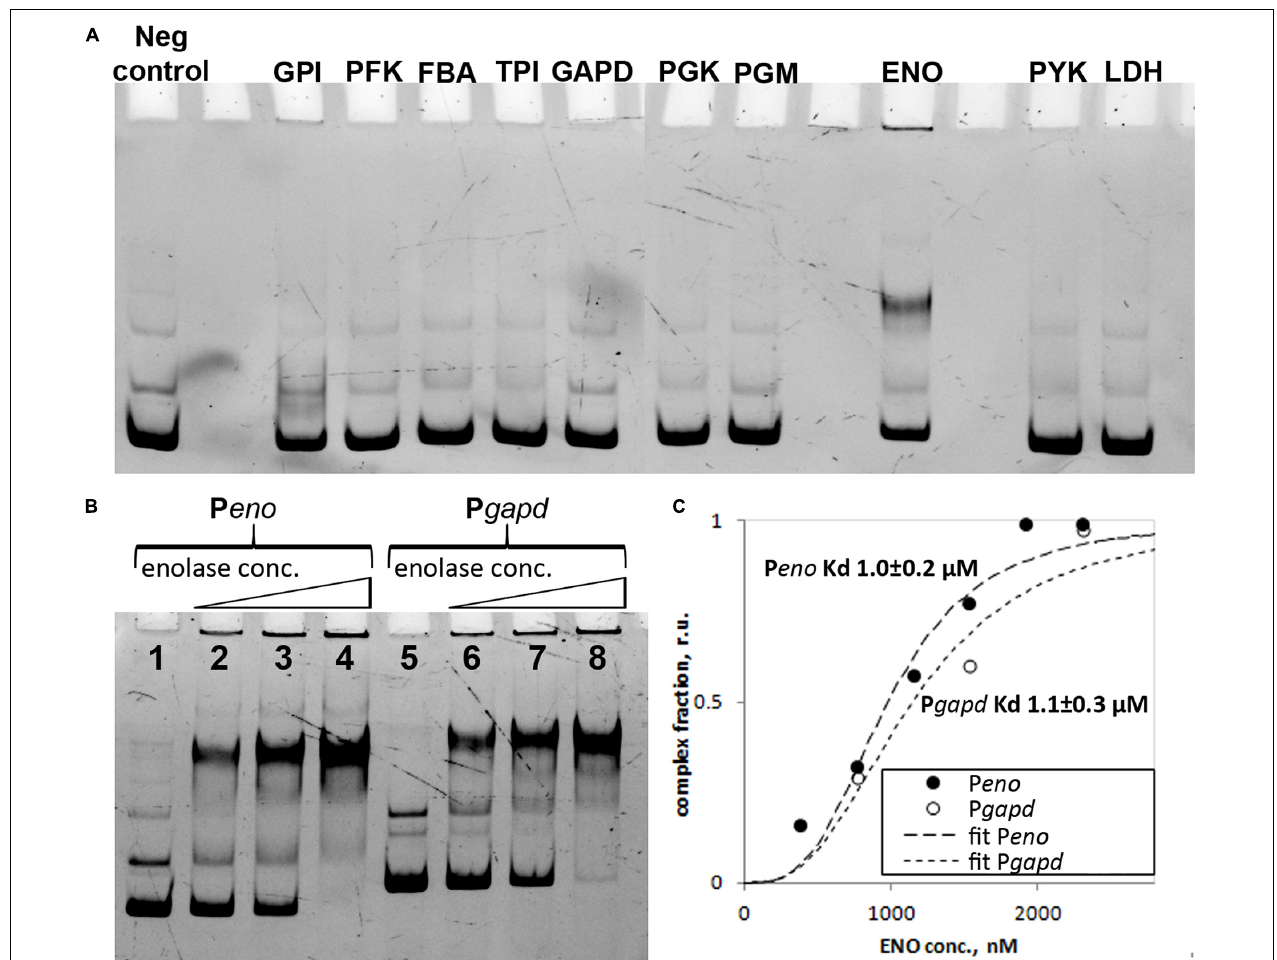
FIGURE 5 | (A) Electrophoretic mobility shift assay (EMSA) of the DNA-binding activity of glycolysis proteins from M. gallisepticum , enolase gene promoter region was used as a probe (P eno ), 250 nM: glucose-6-phosphate isomerase (GPI) 879 nM, 6-phosphofructokinase (PFK) 863 nM, fructose-bisphosphate aldolase (FBA) 2255 nM, triosephosphate isomerase (TPI) 1605 nM, glyceraldehyde-3-phosphate dehydrogenase (GAPD) 127 nM, phosphoglycerate kinase (PGK) 1589 nM, phosphoglycerate mutase (PGM) 1038 nM, enolase (ENO) 769 nM, pyruvate kinase (PYK) 332 nM and L-lactate dehydrogenase (LDH) 1155 nM. (B) EMSA of M. gallisepticum enolase with different DNA fragments including promoter regions of enolase (P eno ) and glyceraldehyde-3-phosphate dehydrogenase (P gapd ) genes. Lanes: 1 – free DNA fragment (P eno ), 2 – P eno + 769 nM of enolase, 3 – P eno + 1539 nM of enolase, 4 – P eno + 2308 nM of enolase, 5 – free DNA fragment (P gapd ), 6 – P gapd + 769 nM of enolase, 7 – P gapd + 1539 nM of enolase, 8 – P gapd + 2308 nM of enolase. (C) Identification of M. gallisepticum enolase (ENO) binding constant using protein titration in EMSA experiment and Hill equation. P eno DNA fragment was used for the binding constant